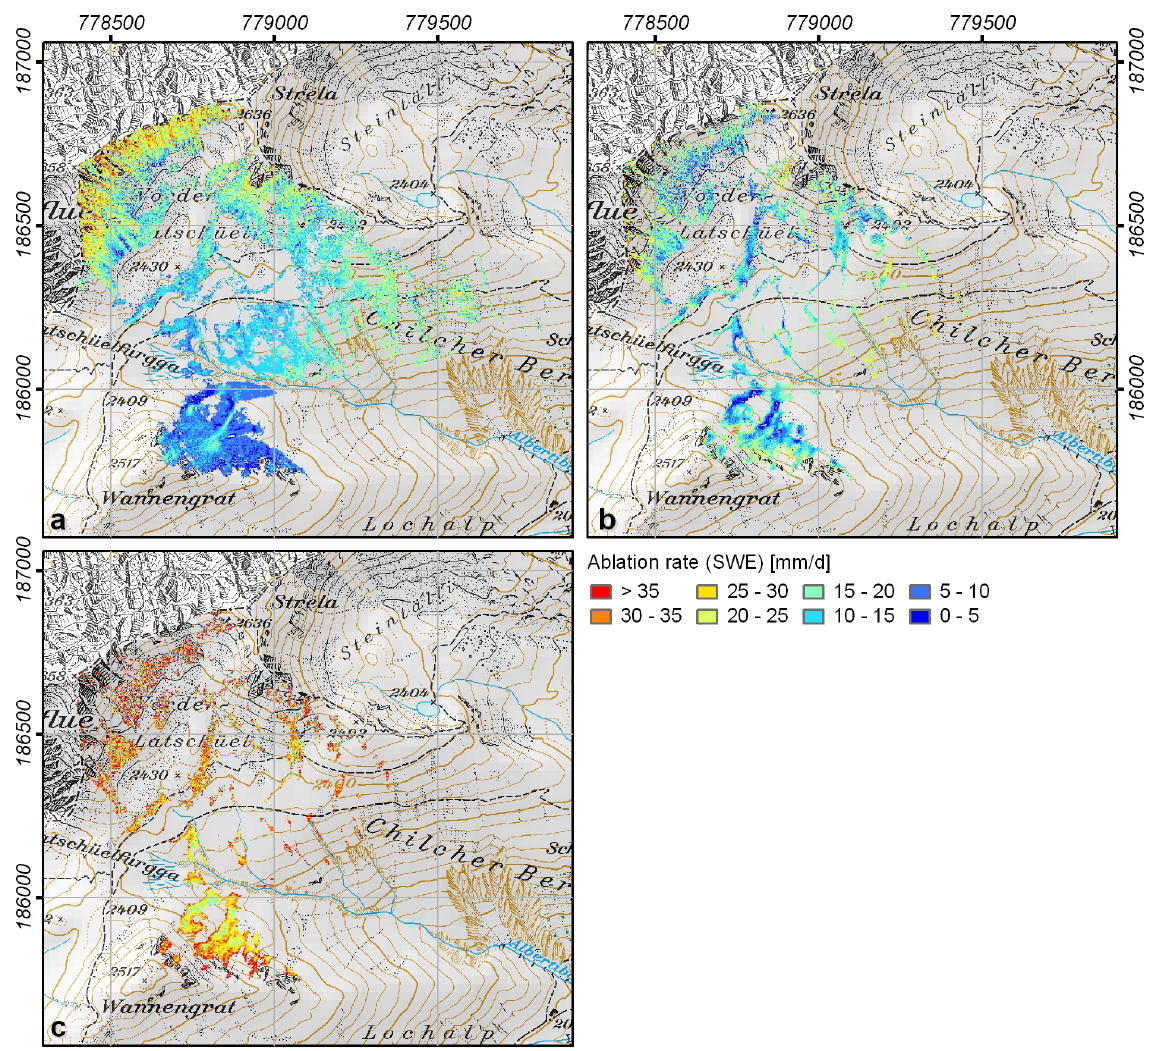
Fig. 7. Daily ablation rates ( SWE ) averaged for the time periods 26 April–13 May (a) , 13 May–2 June (b) and 2 June–10 June (c) . (base map: Pixelkarte PK25 © 2009 swisstopo